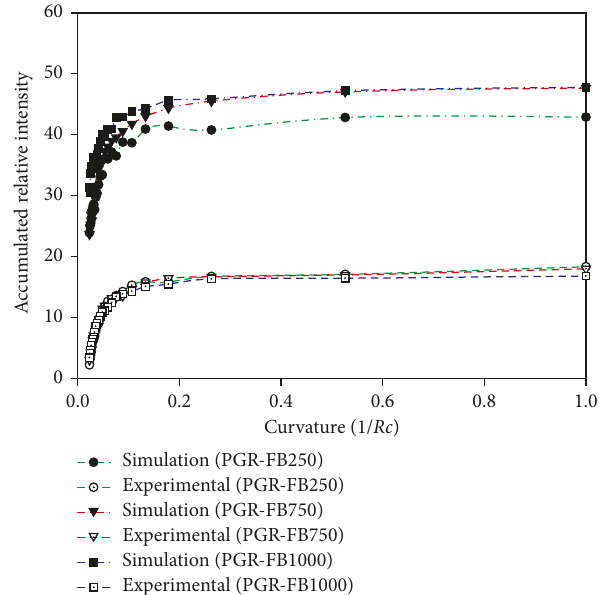
Figure 22: Comparison of simulation and experiment for the half cone jig